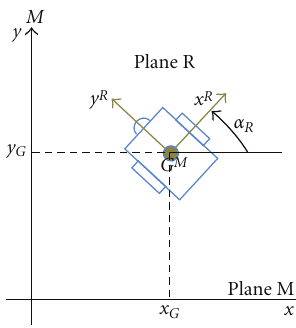
Figure 14: Relation between plane M and plane R , both in R 2 .